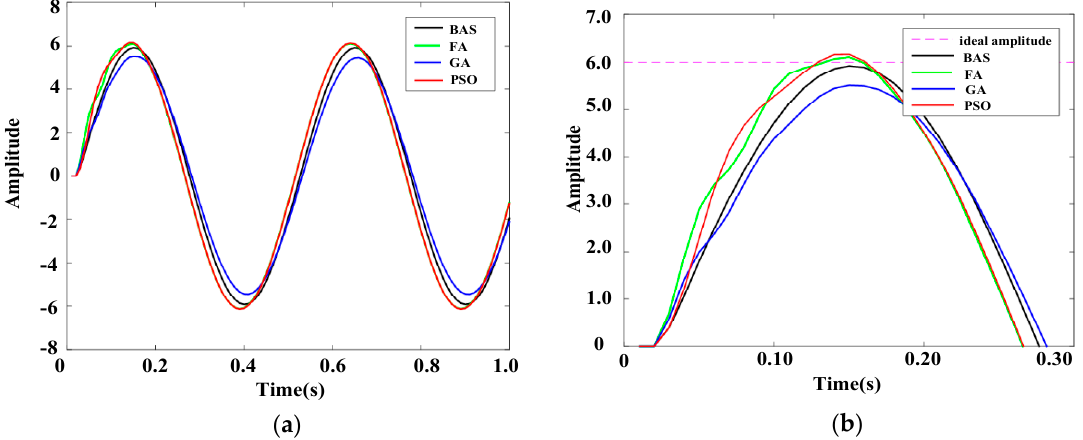
Figure 12. Response curves of the sinusoidal signal whose amplitude is 6. ( a ) Whole response curves. ( b ) Local amplification curves.